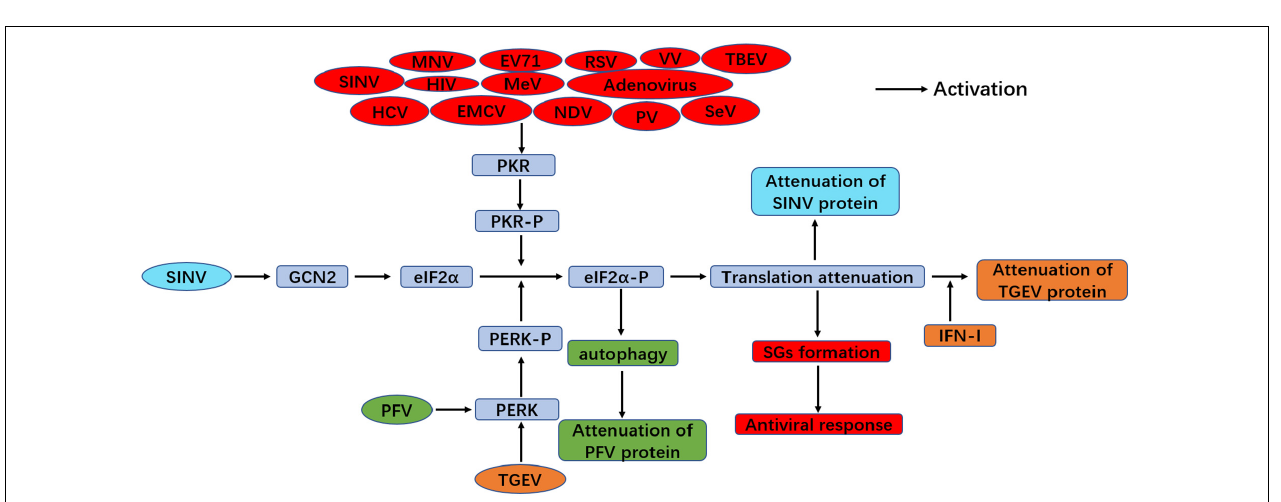
FIGURE 4 | Antiviral response of the ISR during viral infection. PERK-eIF2 α signaling suppresses viral replication through inducing IFN-I production and eIF2 α phosphorylation-mediated translation attenuation with TGEV infection (orange color). PFV infection inhibits viral replication through PERK-mediated autophagy (green color). In addition, viral infection induces SGs formation through PKR-eIF2 α phosphorylation and plays antiviral response, such as MNV, EV71, RSV, VV, TBEV, SINV, HIV, MeV, Adenovirus, HCV, EMCV, NDV, PV and SeV (red color). GCN2-eIF2 α signaling inhibit viral replication upon SINV infection (blue